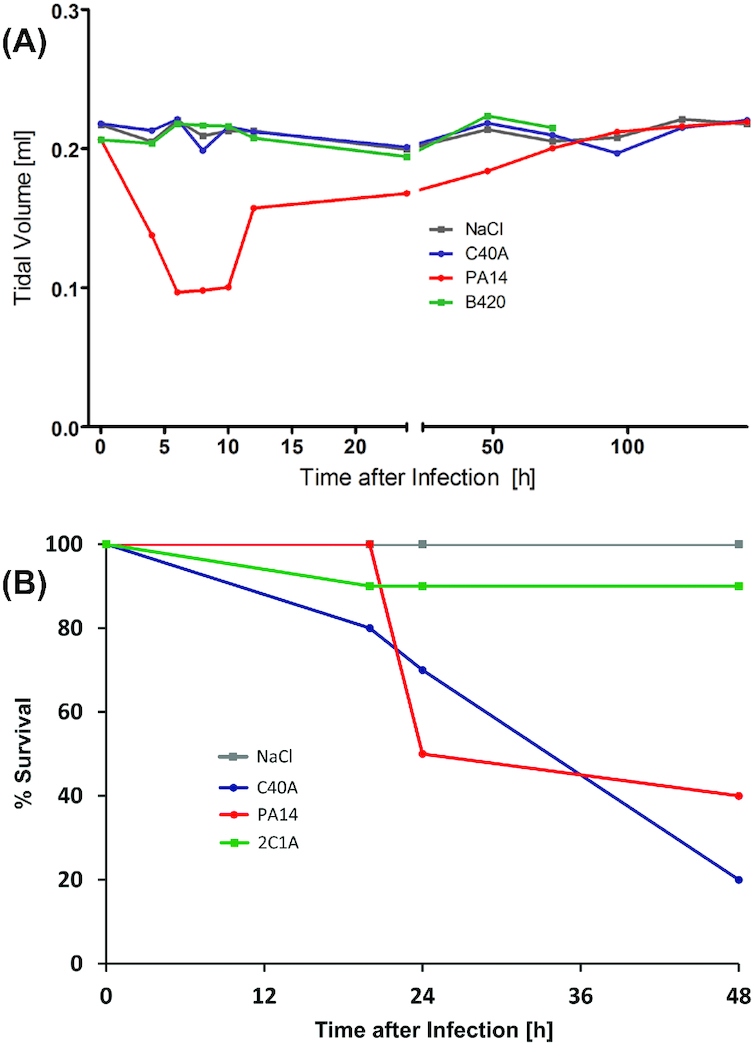
Virulence potential of clone C. The diagrams display the outcome of virulence tests for clone C (here termed C40A) in comparison to other clonal lineages (Hilker et al. 2015). The strains were tested in a murine airway infection model and in a wax moth (Galleria melonella) larvae infection model. For comparison of the severity of the mouse infection, lung pathology and cytokine responses were monitored and parameters such as body weight or rectal temperature were assessed. In addition, headout spirometry was performed on the infected mice. For negative controls, mice received NaCl solution. As an example for the different degrees of virulence in mouse infection, a diagram of displaying the development of tidal volumes are shown upon infection with clones C/C40A, B420 and PA14 (panel A). While clone PA14 inflicted a severe lung infection phenotype, clone C and B420 did not display much virulence potential in this assay. In contrast, clone C displayed high virulence in the G. melonella larvae infection model (panel B). While for some clones (such as 2C1A) most larvae could overcome the infection, clone C was found among the strains with the highest virulence in this invertebrate assay killing even higher proportions of the infected larvae than clone PA14.